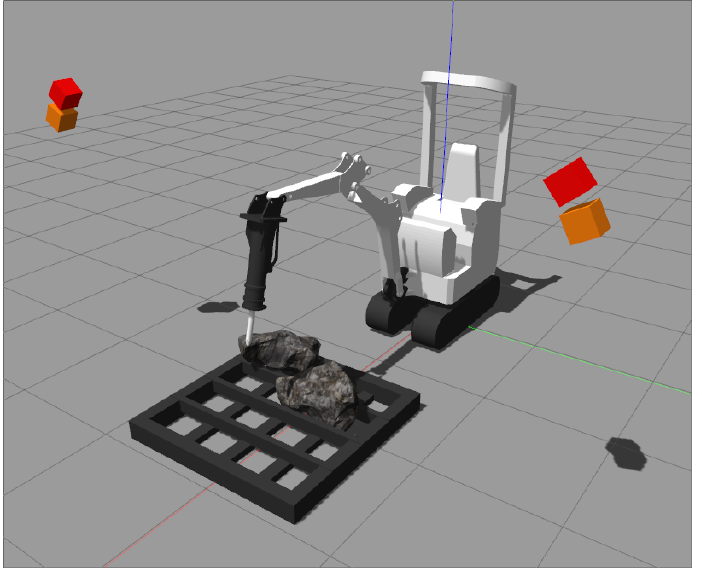
Figure 19. Simulation of the Bobcat E10 mini-excavator and a simplification of its working environ- ment. The red and orange boxes correspond to the simulated cameras and